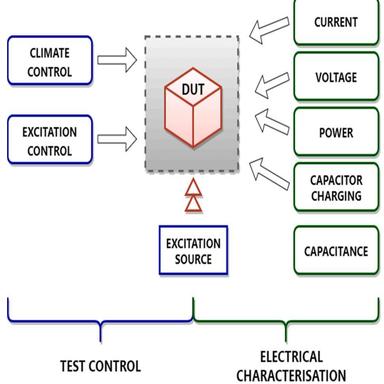
General block diagram of a vibration powered energy harvesting experimental setup typically used for electrical characterisation and performance measurements of device under test (DUT). .